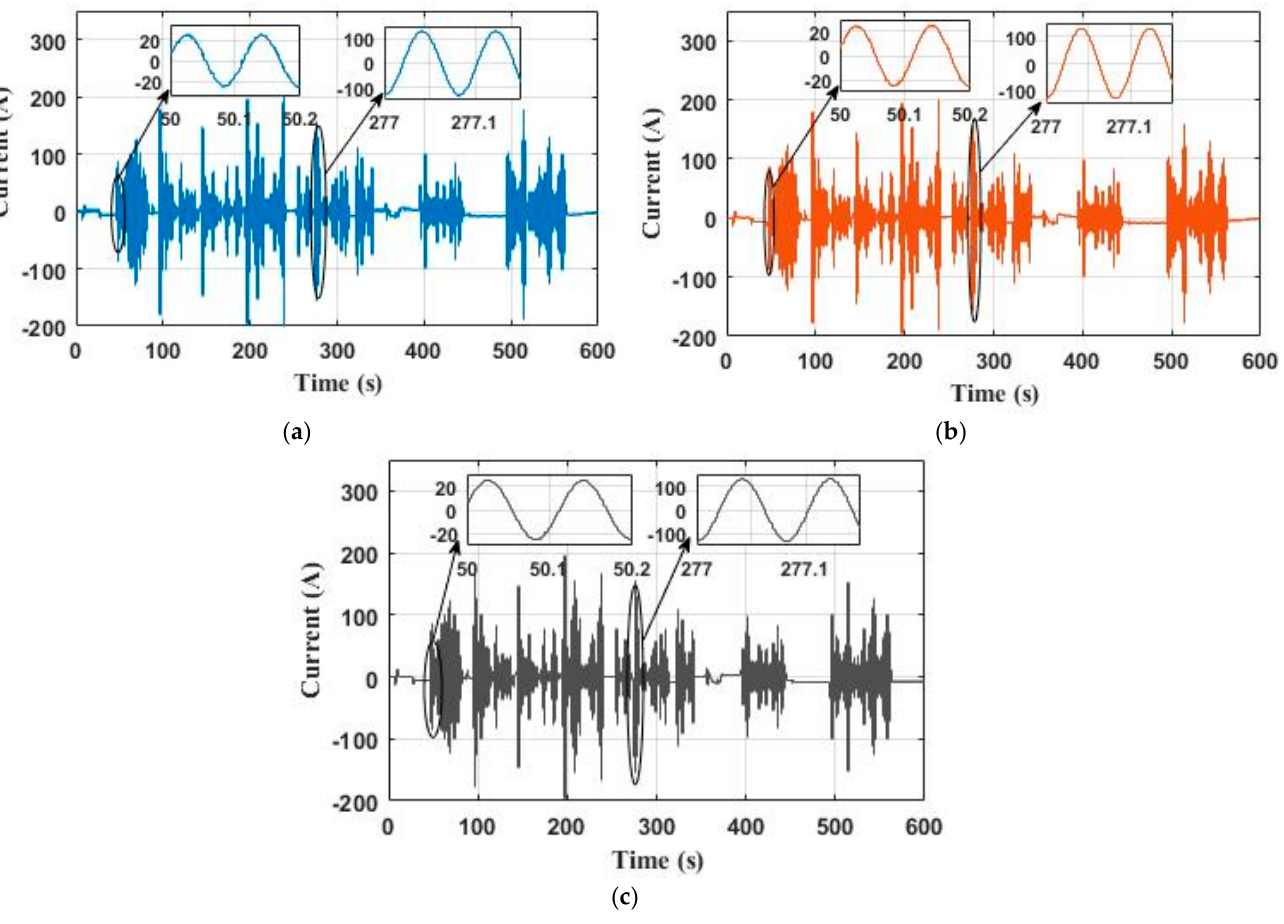
Figure 19. The phase current waveform with di ff erent techniques ( a ) DTC; ( b ) FDTC; ( c ) MPDTC.